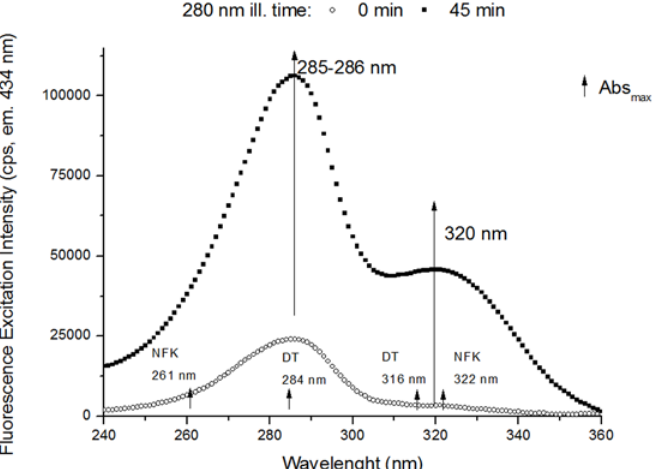
Fig 10. Fluorescence excitation spectra of human plasminogen (434 nm emission). Fluorescence excitation spectra (emission at 434 nm) obtained before and after 280 nm continuous illumination (45 min) of human plasminogen in solution. 280 nm illumination leads to an increase in excitation intensity at the peak located at ~285 – 286 nm and to the formation of a new peak at 320 nm. Small increasing arrows indicate the wavelengths of maximum absorption (Abs max ) of DT, Kyn and NFK in